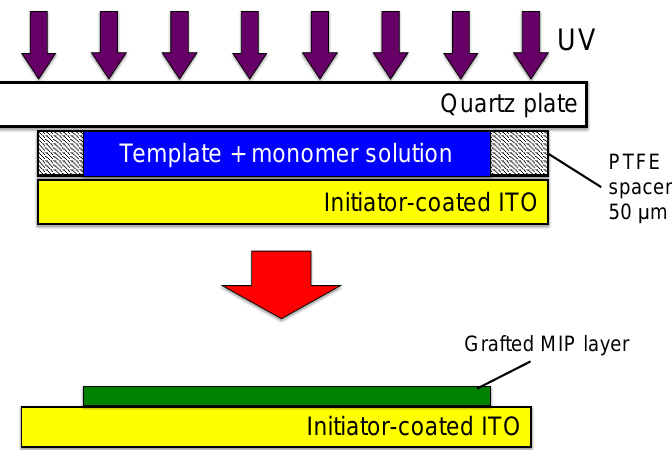
Figure 1. Scheme of the procedure of MIP grafting on the initiator-coated ITO by UV irradiation.